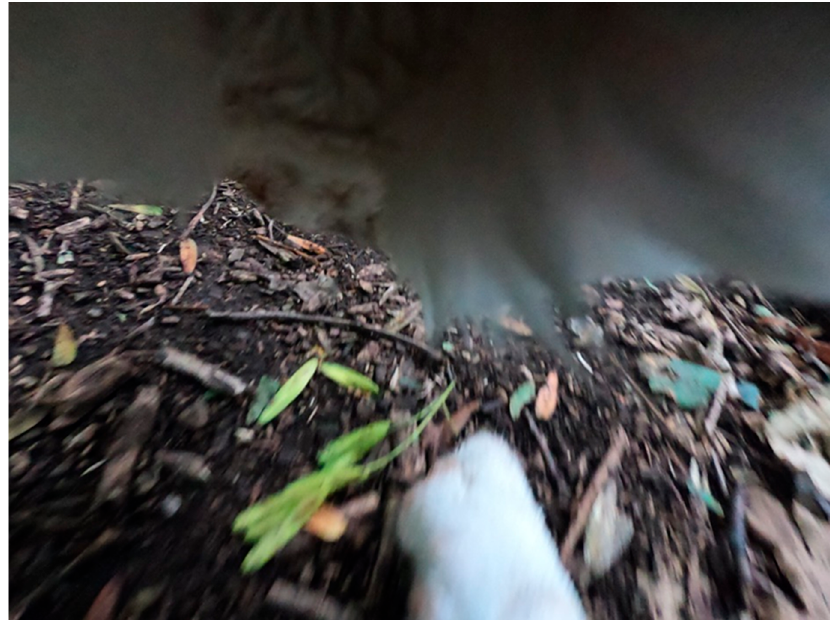
Figure 1. A Year with The Meadows © ; O’Brien 2021.